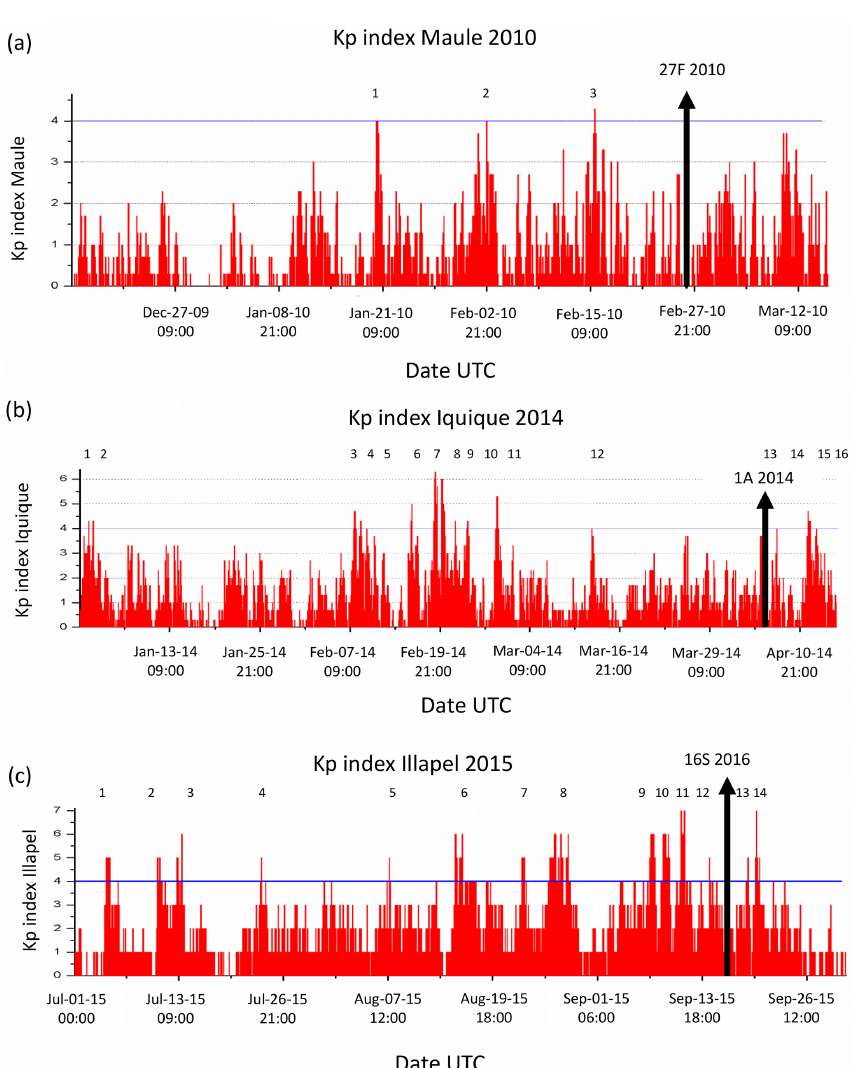
Figure 2. The Kp magnetic activity index for the periods prior to the Maule 2010 (a) , Iquique 2014 (b) , and Illapel 2015 (c) earthquakes (NOAA SPIDR) (WDCFG, Kyoto